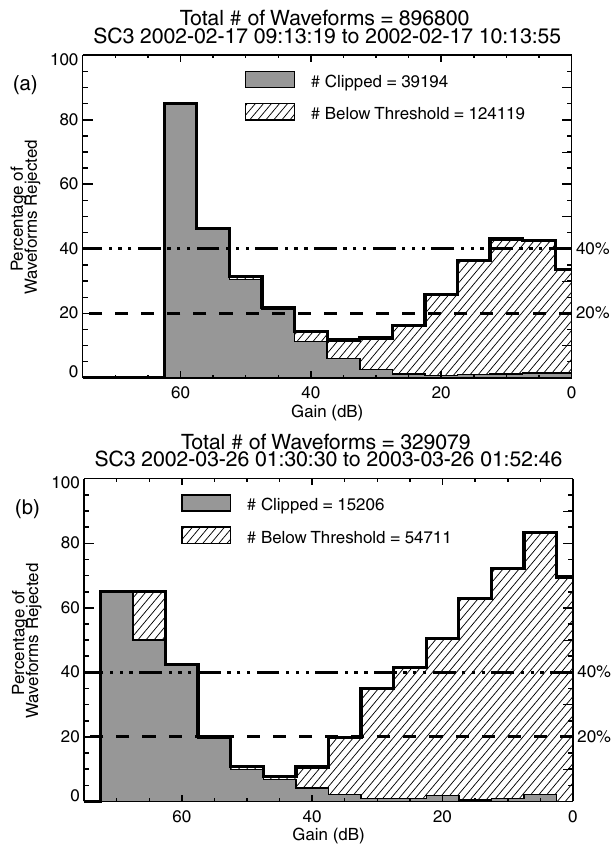
Fig. 5. Histograms of the percentages of waveforms in each gain state rejected for (a) spacecraft 3 on 17 February 2002 and (b) spacecraft 3 on 26 March 2002. The solid black line indicates the total percentages of waveforms rejected in each gain state. The gray shaded area indicates the percentage of clipped waveforms and the line-filled area indicates the percentage of waveforms below the minimum amplitude